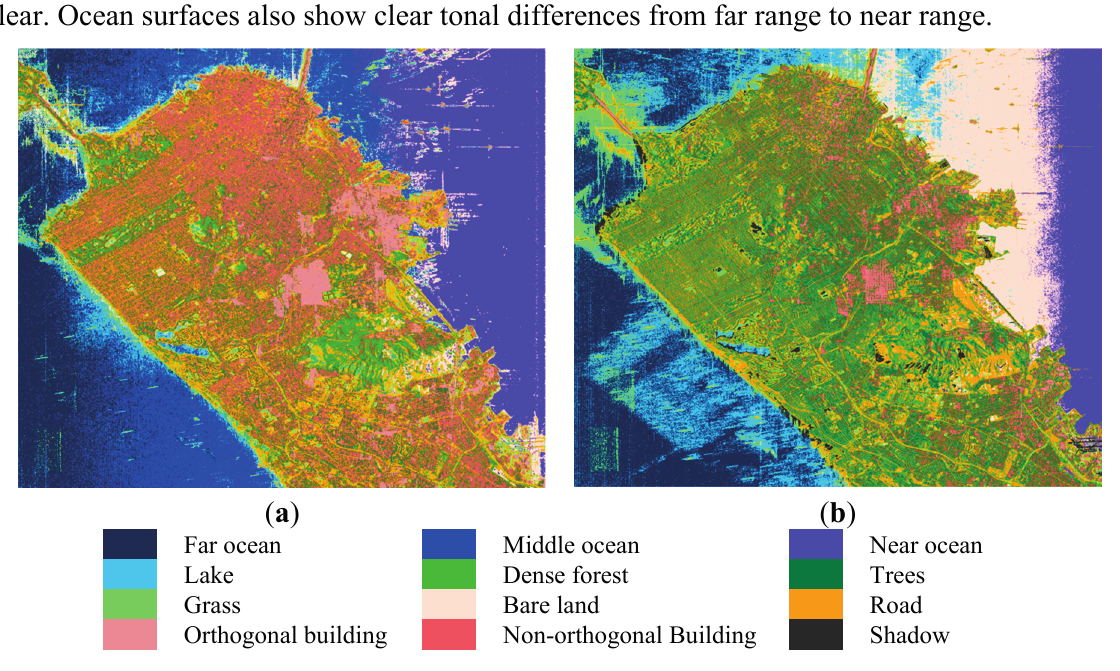
Figure 4. Classification results of proposed method and Wishart supervised method on L-band data; ( a ) proposed method; ( b ) Wishart supervised